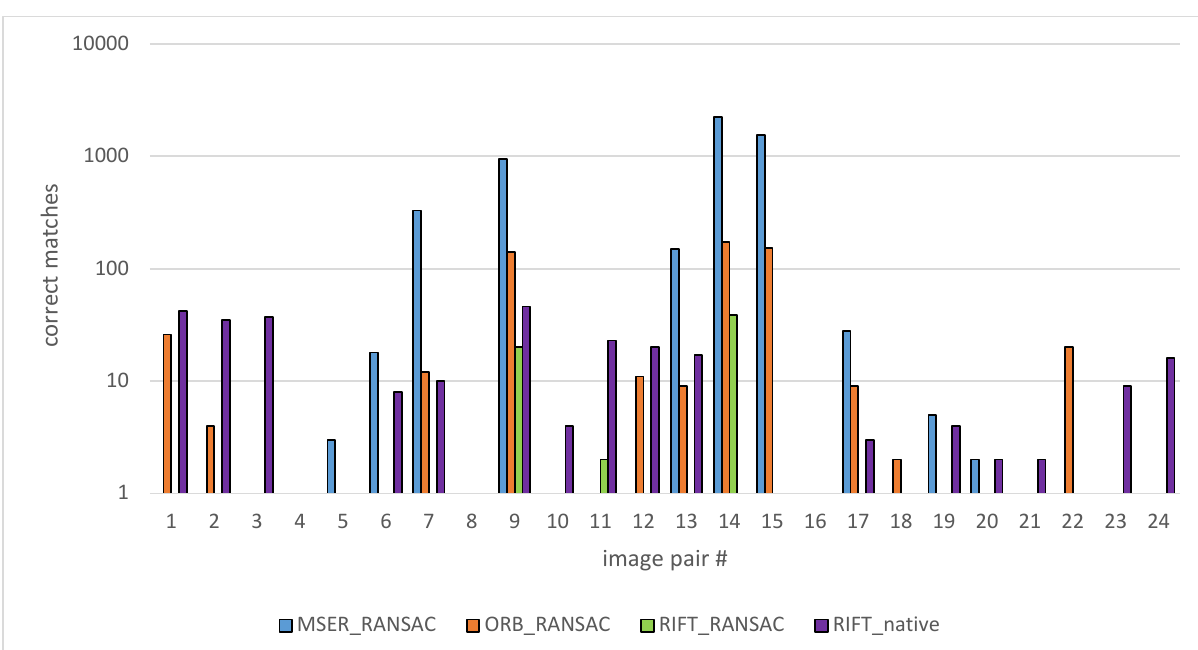
Figure 3. Total number of correct matches shown on a logarithmic scale of every image pair for the four best performing algorithms MSER_RANSAC, ORB_RANSAC, RIFT_RANSAC, and RIFT_native number of all correct matches determined by the different approaches approaches for the 24 image pairs. The total number of feature points is provided within the dataset. The image pairs are serially (fig. 2, numbered from 1 to 24. It is easy to see that for example the image pair 16 could not be matched by any of the algorithms with a good result in opposite to e.g. the image pair 9 where every approach shows better results highlighted in the respective column in green. For an easier comparison the matching scores (ratio) and the number of correct matches of the four best